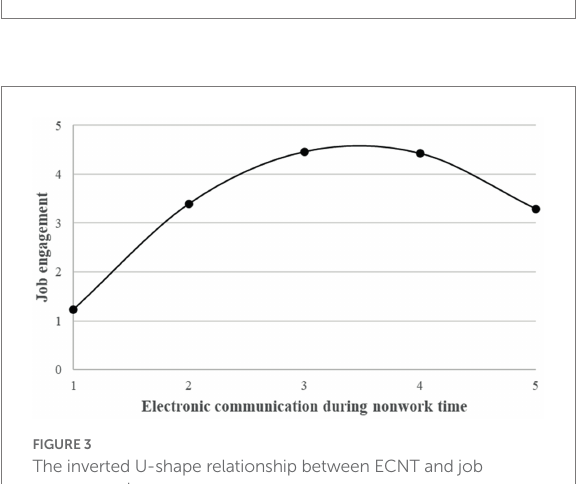
FIGURE 2 The U-shape relationship between ECNT and employee withdrawal behavior.